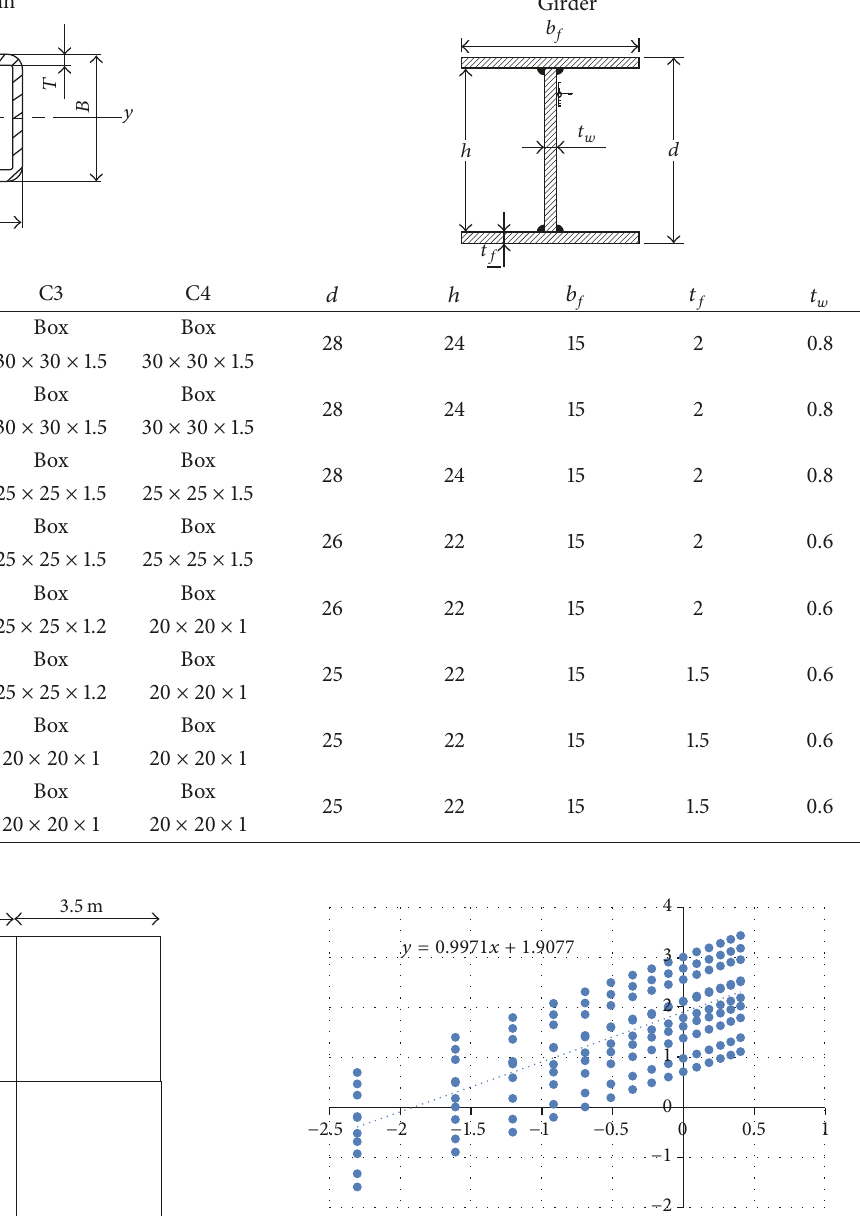
Figure 2: Probabilistic seismic demand (drift) for the 5-story RC